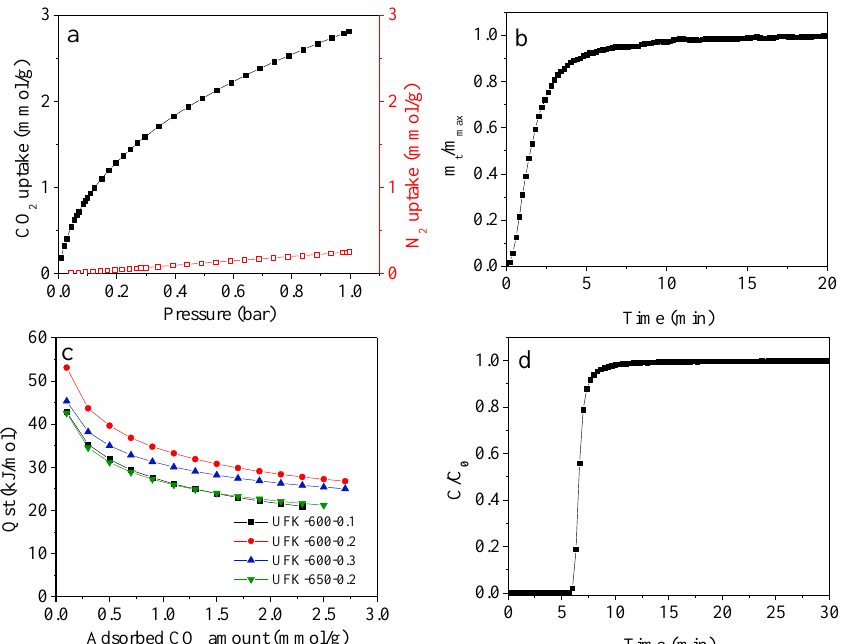
Figure 7. ( a ) CO 2 and N 2 adsorption isotherms of UFK-600-0.2 at 25 ◦ C and 1 bar, ( b ) CO 2 adsorption kinetics at 25 ◦ C for UFK-600-0.2, ( c ) Qst on selected sorbents and ( d ) breakthrough curves of UFK-600-0.2. Adsorption conditions: gas pressure 1 bar, adsorption temperature 25 ◦ C, gas flow rate 10 mL/min, inlet CO 2 concentration 10 vol.%.